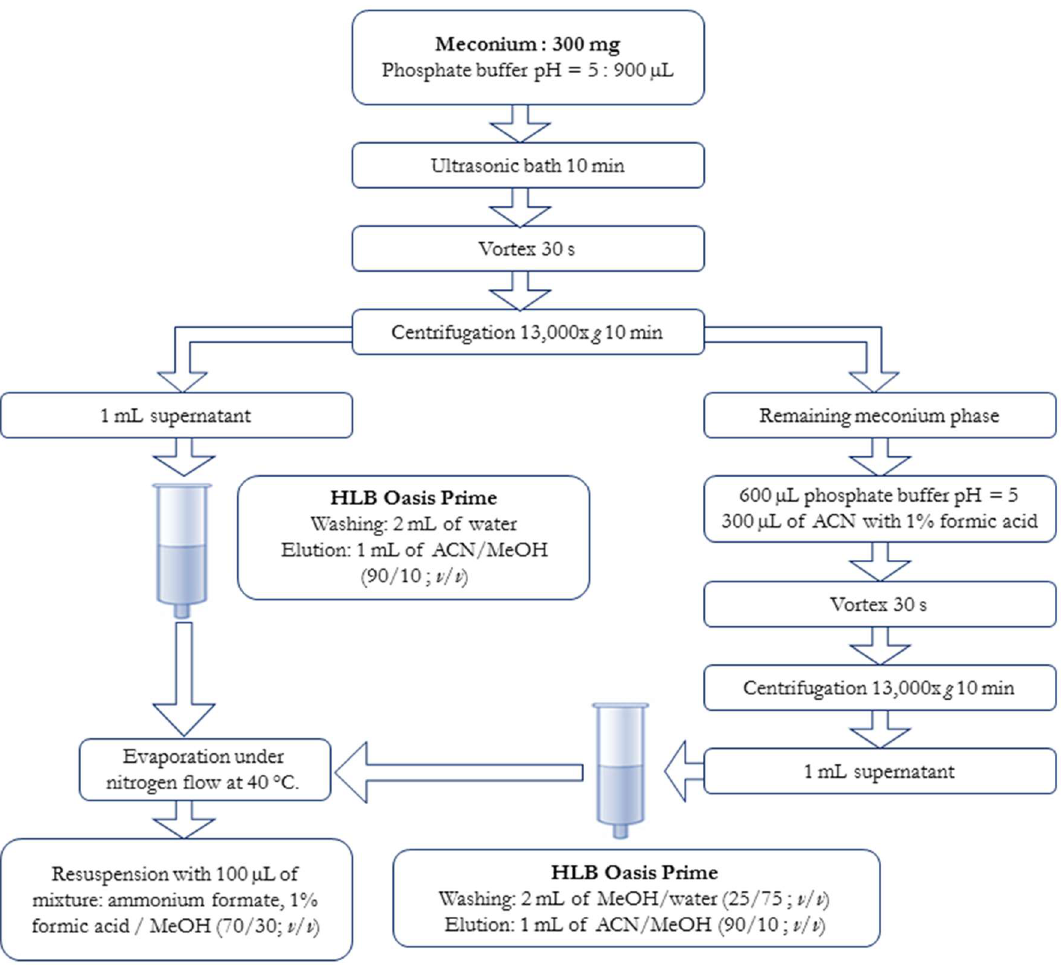
Figure 1. Schematic representation of the extraction procedure.